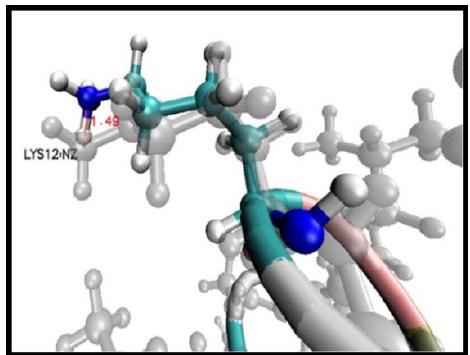
Figure 2. Atomic representation of the amino acid Lys12 in peptide +5 (color) compared with peptide +2 (gray); the nitrogen atom (blue color) is displaced 1.49 Å to achieve energy minimisation.